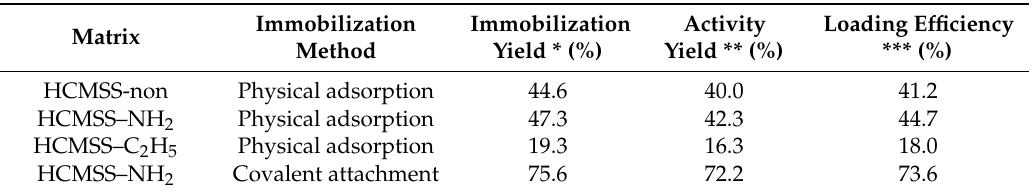
Table 1. Immobilization of NPST-AK15 alkaline protease onto hollow core-mesoporous shell silica (HCMSS) nanospheres. The standard deviations were in the range of 1%–3%.